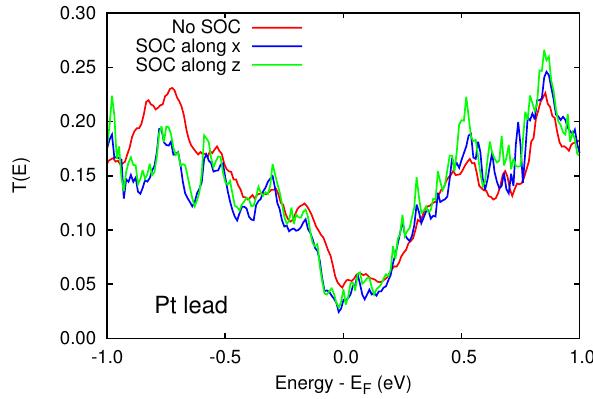
Figure 10. Transmission function of the asymmetric Pt lead device with and without spin-orbit interaction. In presence of SOC, we report T ( E ) as a function of the spin orientation with respect to the interfaces: x is parallel to the interface; z is perpendicular to the interface, i.e., parallel to the transport